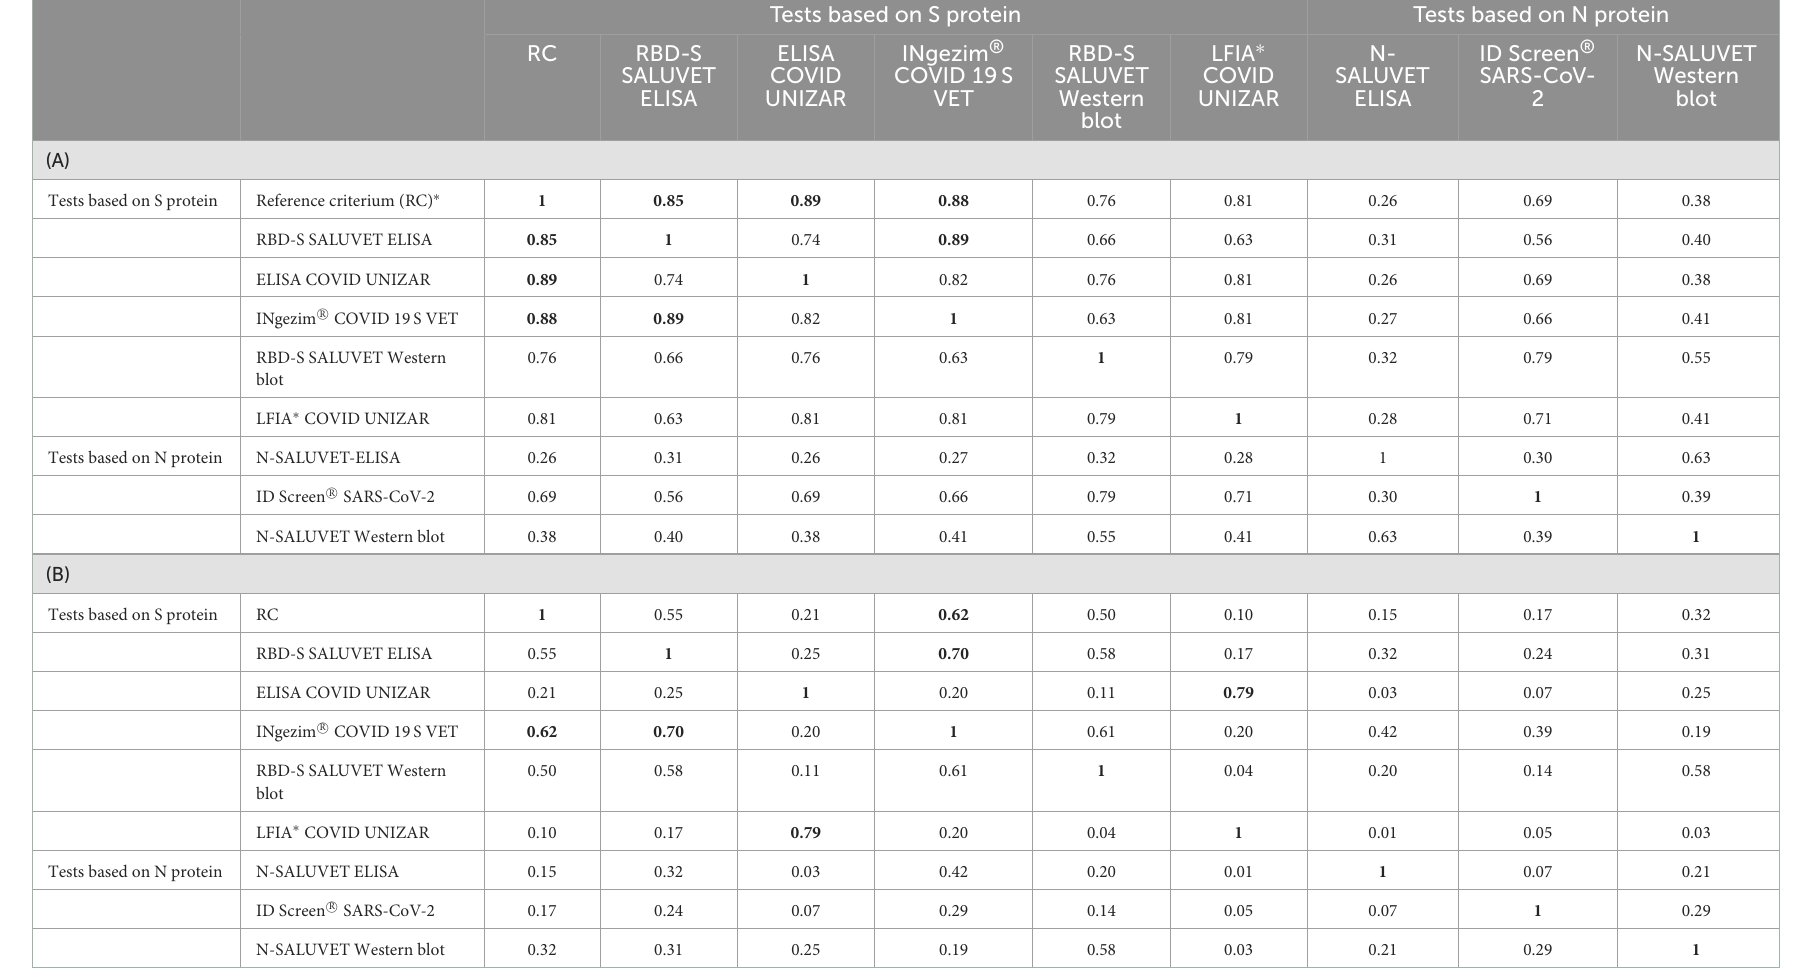
TABLE 3 Test agreement ( κ -values) between serological tests developed for cats (A) and dogs